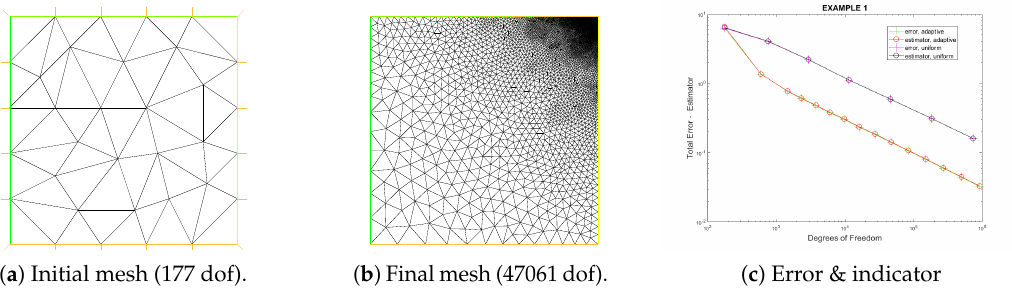
Figure 1. Some meshes, and error and indicator for the uniform and adaptive refinements vs.